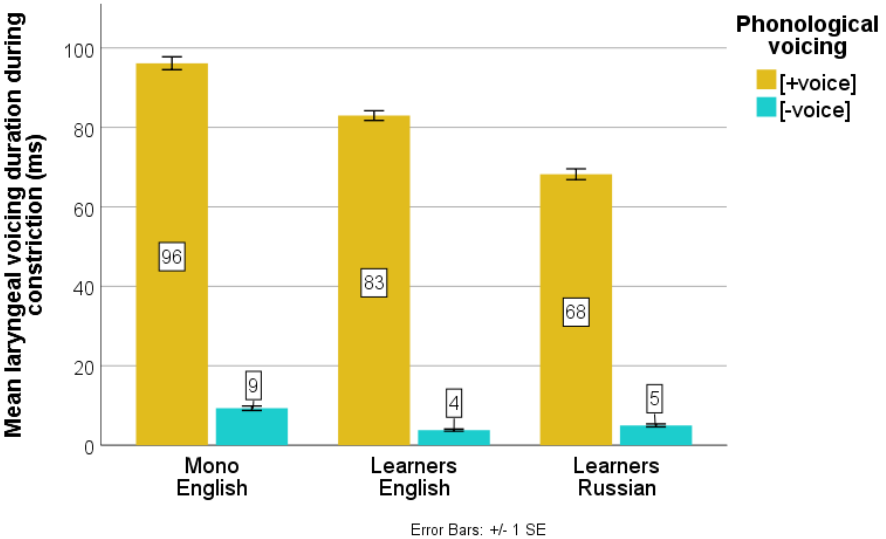
Figure 18. Mean duration of voicing during constriction of final obstruents in monolingual controls’ and learners’ English; learners’ Russian is provided for comparison.